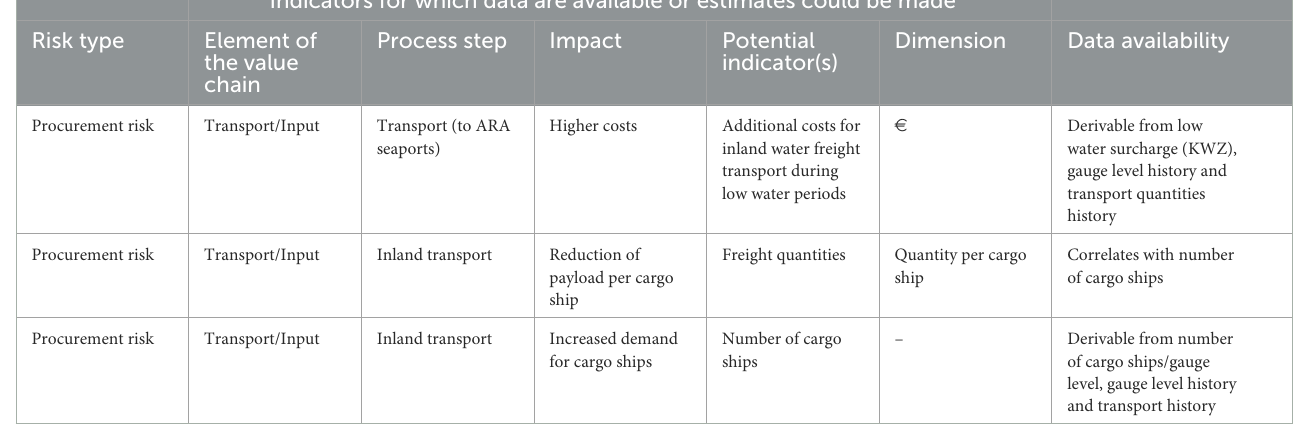
TABLE 2 List of potential indicators for corporate climate risk (excerpt for risk factor “impact”). Indicators for which data are available or estimates could be